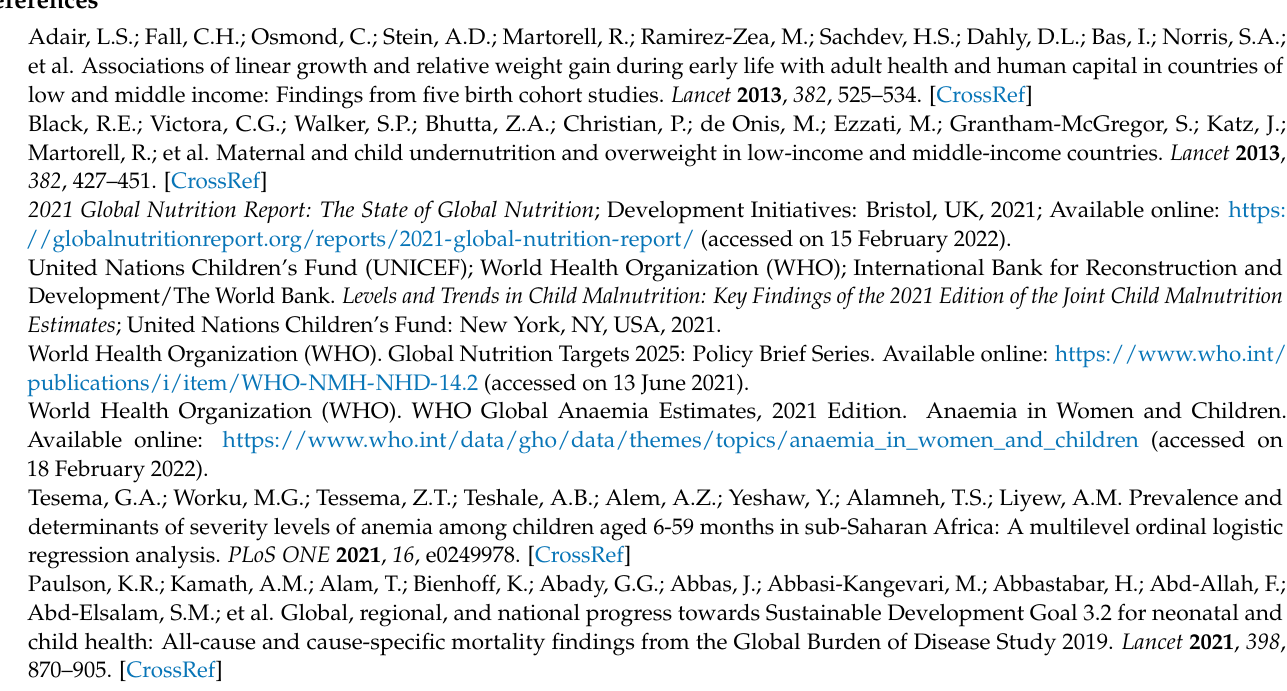
Figure A1. Residual analysis for model M8 considering mild-to-severe stunting.